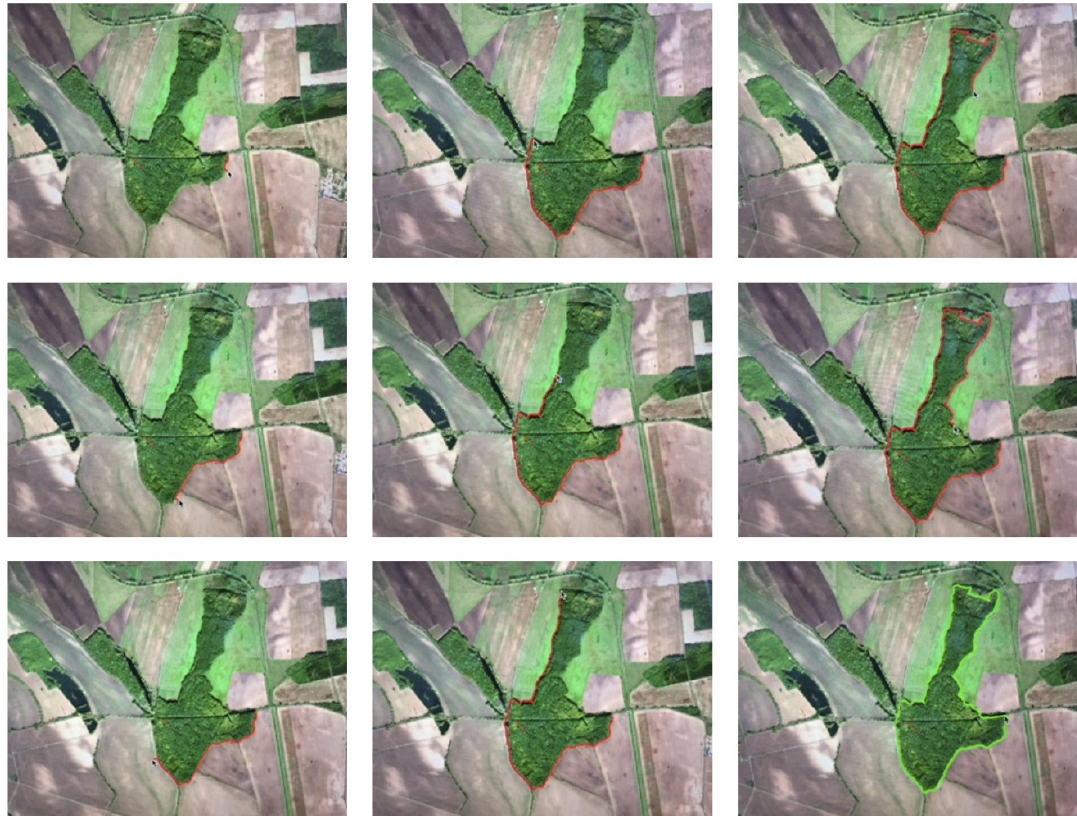
Figure 3. An example of the semi-automatic segmentation showing consecutive building of the segmentation curve, the intermediate steps (from top left down to the bottom right) are in red, the final result is in green on bottom right.